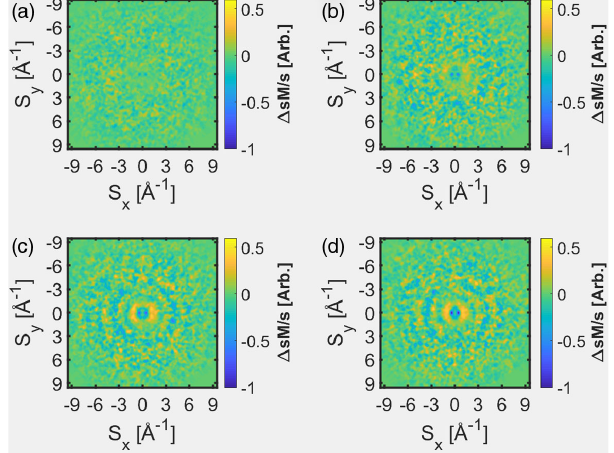
FIG. 8. Measured modified diffraction difference patterns — Δ sM ð s Þ . (a) Pattern averaged over delays from − 250 to − 150 fs. (b) Pattern averaged over delays from − 50 to 50 fs. (c) Pattern averaged over delays from 200 to 300 fs. (d) Pattern averaged over delays from 500 to 600 fs.